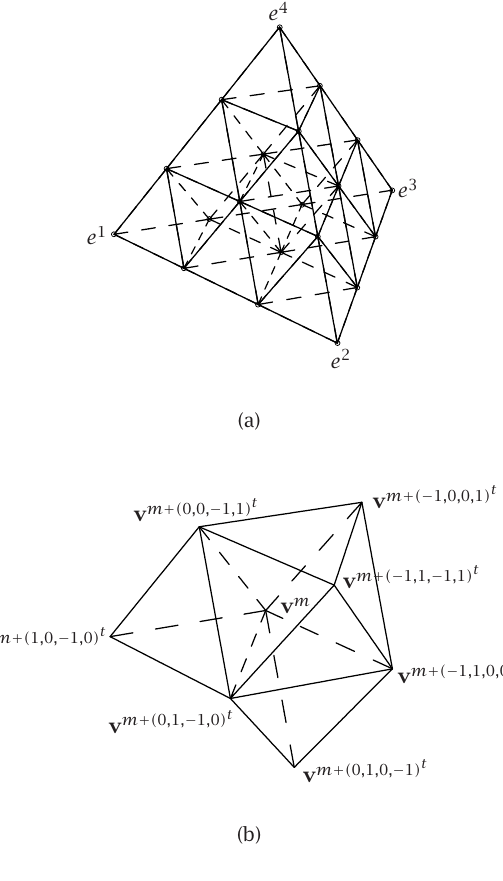
Figure 4.1 . The polytope decomposition Ξ of ∆ for r = 2 and local figure of Ξ